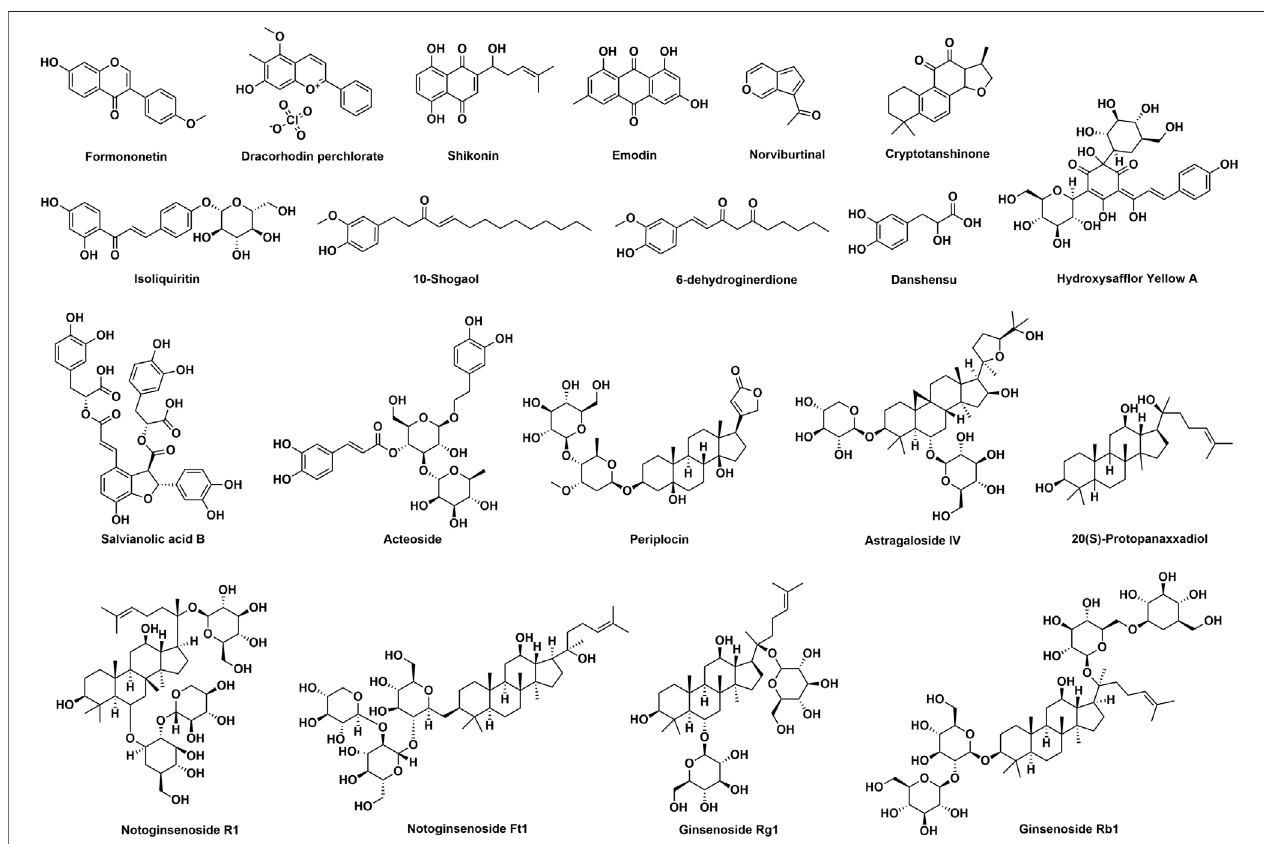
FIGURE 2 | Chemical structures of components isolated from botanical drugs which possess wound healing activities.